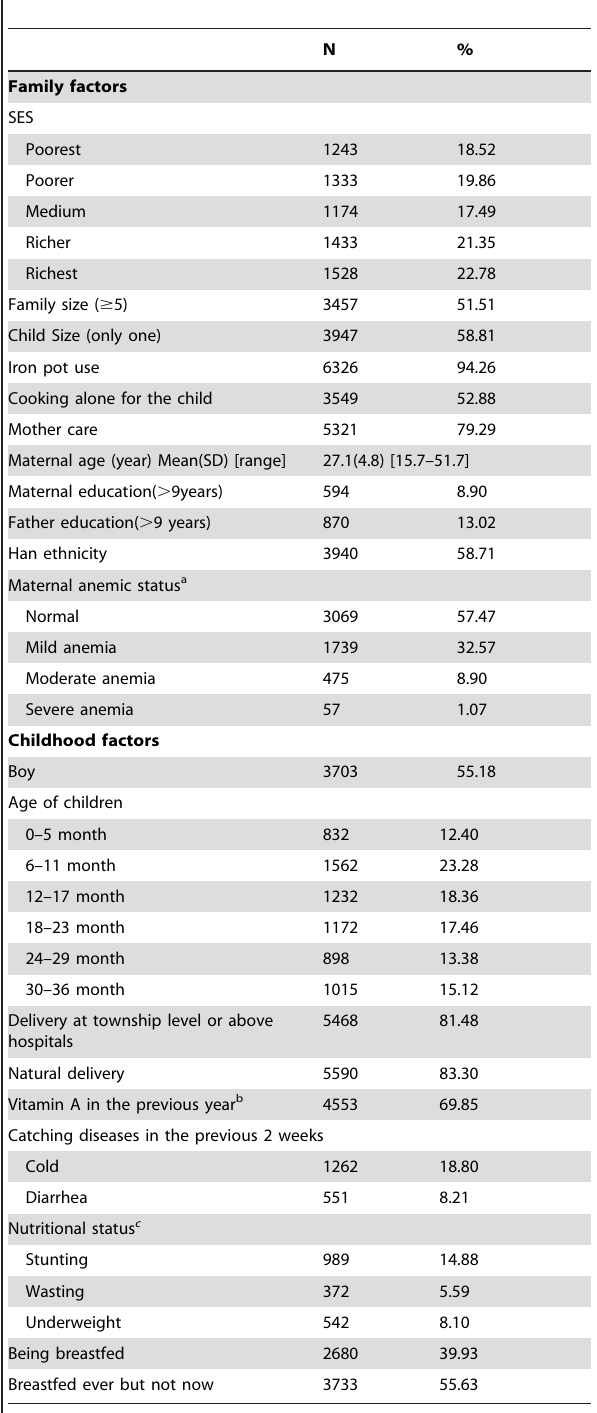
Table 1. Family information and sample characteristics among children under 36 months in rural western